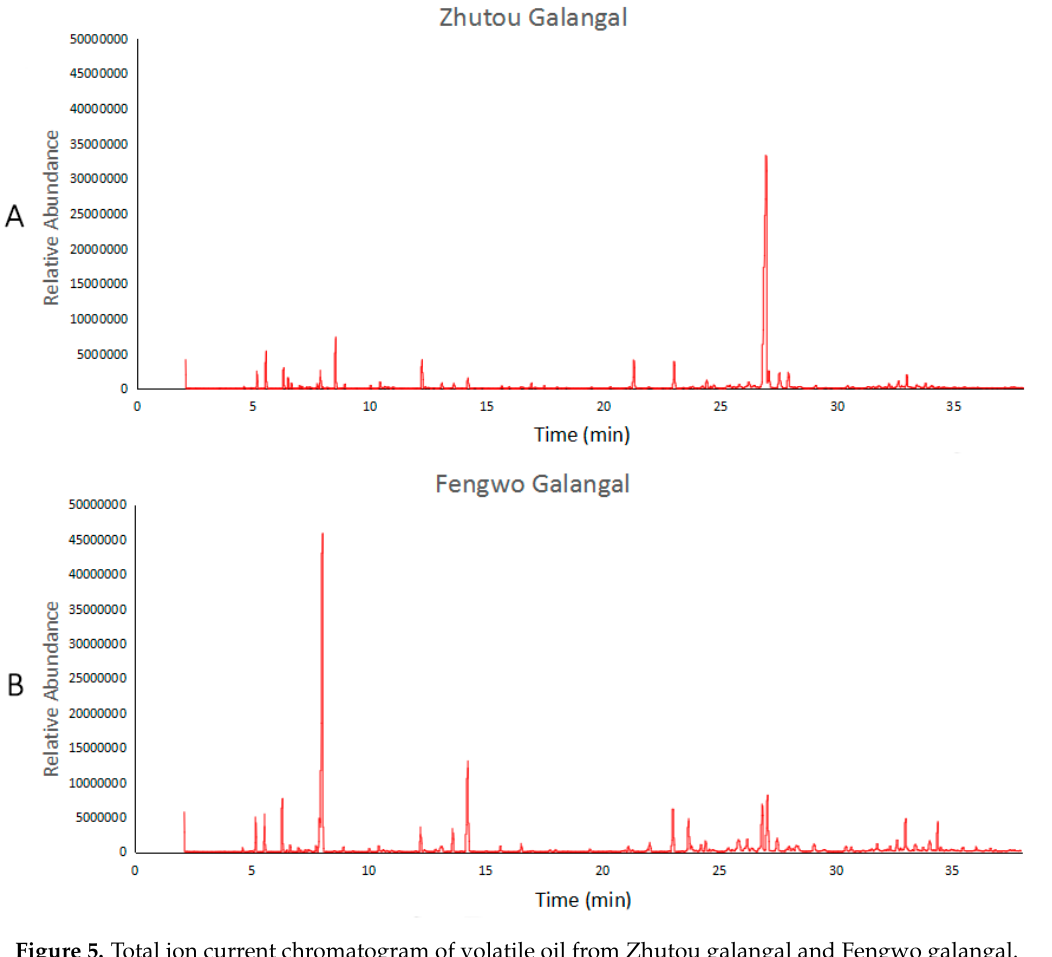
Figure 5. Total ion current chromatogram of volatile oil from Zhutou galangal and Fengwo galangal. ( A ) is the total ion current chromatogram from sample 1ZT, ( B ) is the total ion current chromatogram from sample 2FW).